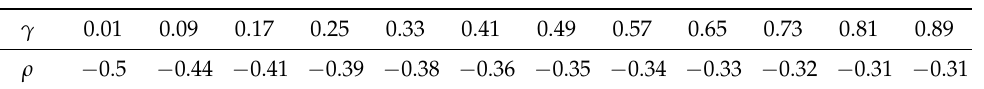
Table 5. Values of the rho of Spearman of the GCC copula for θ = ( − 1/ γ , values of γ , belonging to Configuration 2.